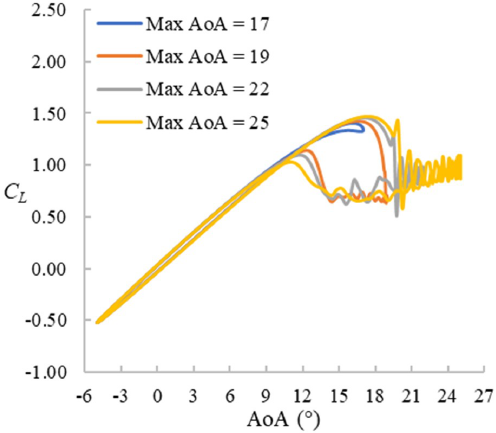
Figure 12. C L hysteresis loops for f = 0.01 cases.